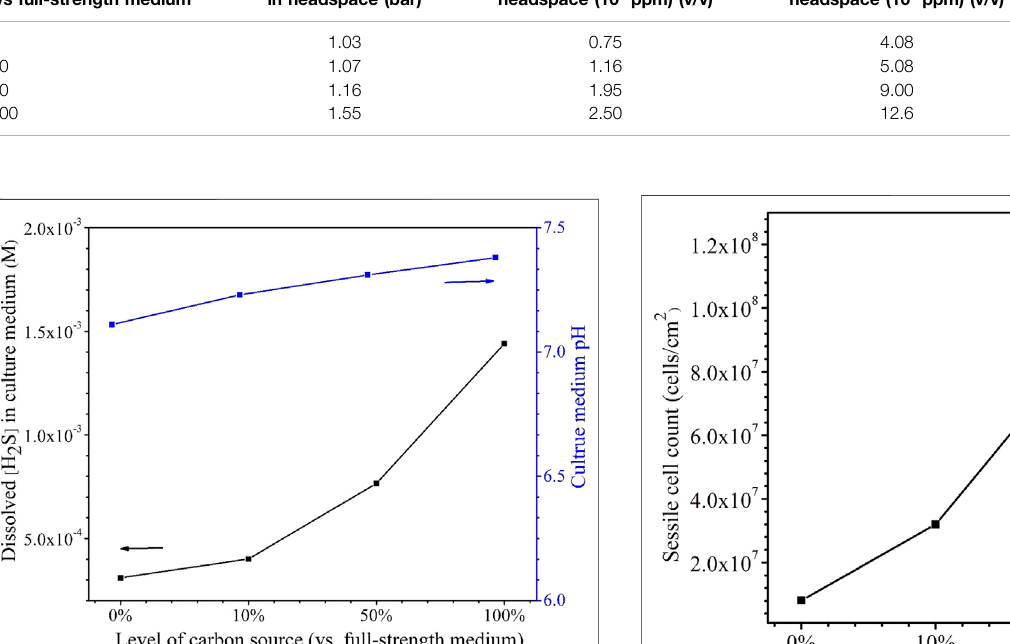
TABLE 5 | Headspace gas concentrations and total pressure as well as calculated [H 2 S] after 14-day carbon starvation incubation in dogbone bottles. Carbon source level (vs full-strength medium